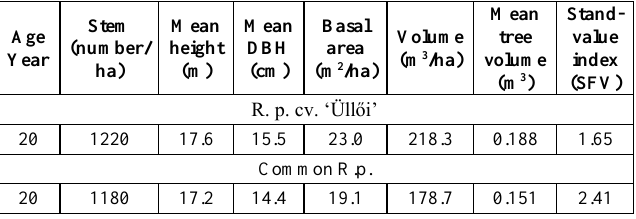
Table 1. Stand structure and quality parameters of the experimental plots